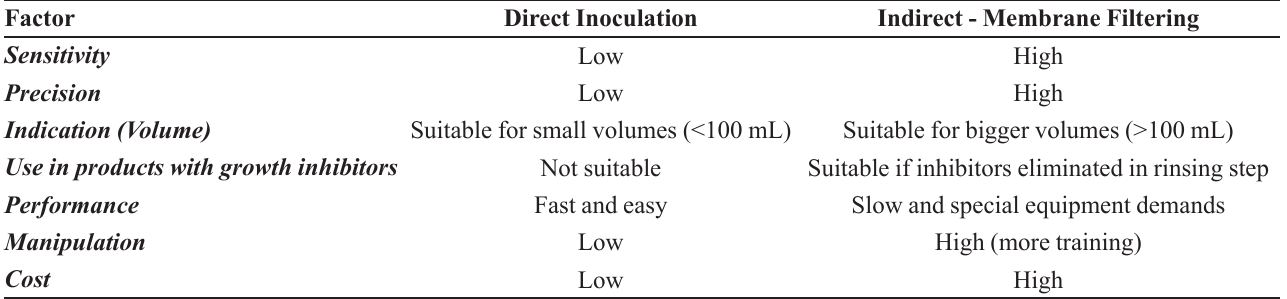
TABLE IV - Comparison of direct inoculation and indirect (membrane filtering) methods